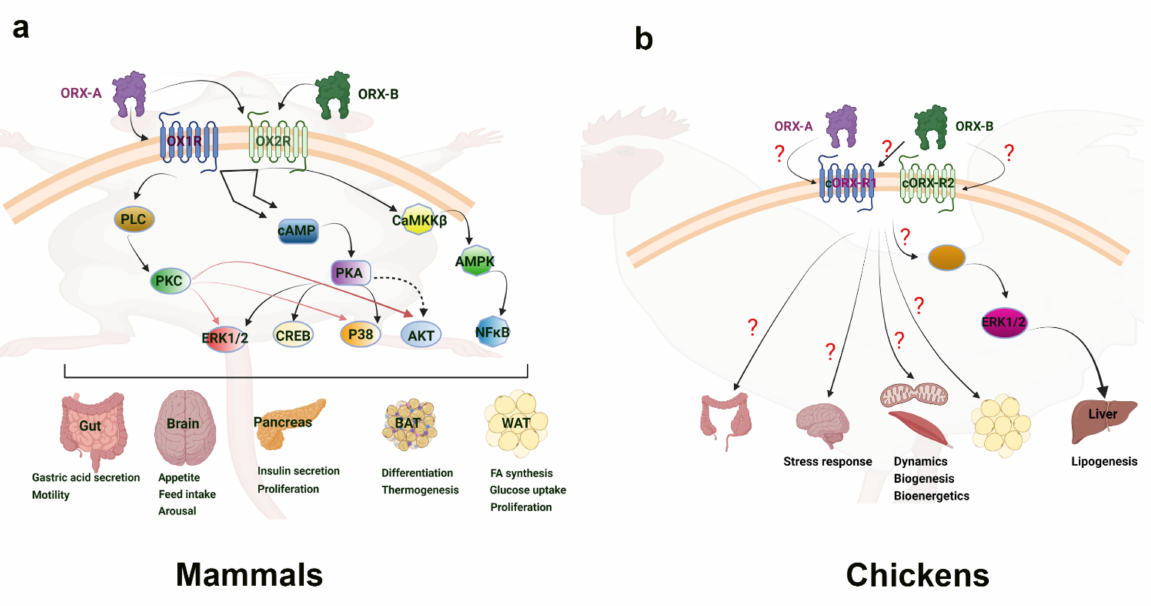
Figure 2. Orexin signaling pathways in mammalian ( a ) and avian species ( b ). “?” means that the downstream mediators are still not known or not well defined. Clear connections have been made to the link between orexin and the activation of energy sensing AMPK within the central nervous system of mammals. This provides a basis for connecting feeding behavior with orexin. Additionally, the ERK1/2 and Akt signaling pathways have been seen in hepatic response to orexin, inducing diverse cellular responses. While the main mechanism of action has yet to be determined, adipose tissue is shown to increase cytokines and other factors in response to orexin. In avian species, the ERK1/2 pathway has also been implicated in the liver response to orexin. Several mitochon- drial related genes were shown to respond to orexin in avian muscle, but the direct mechanism of impact has yet to be elucidated. Culpable molecular signaling pathways have yet to be discov- ered in the avian central nervous system and adipose tissue response to orexin. AKT—Ak strain transforming kinase; AMPK—adenosine monophosphate-activated protein kinase; BAT—brown adi- pose tissue; CaMKK β —Calcium/Calmodulin dependent protein kinase; cAMP—cyclic adenosine monophosphate; cORX-R1; chicken orexin receptor 1; cORX-R2—chicken orexin receptor 2; CREB— cAMP-response element binding protein; ERK1/2—extracellular-signal-regulated kinase 1/2; NF κ B— nuclear factor kappa light chain enhancer of activated B cells; ORX-A—orexin-A;